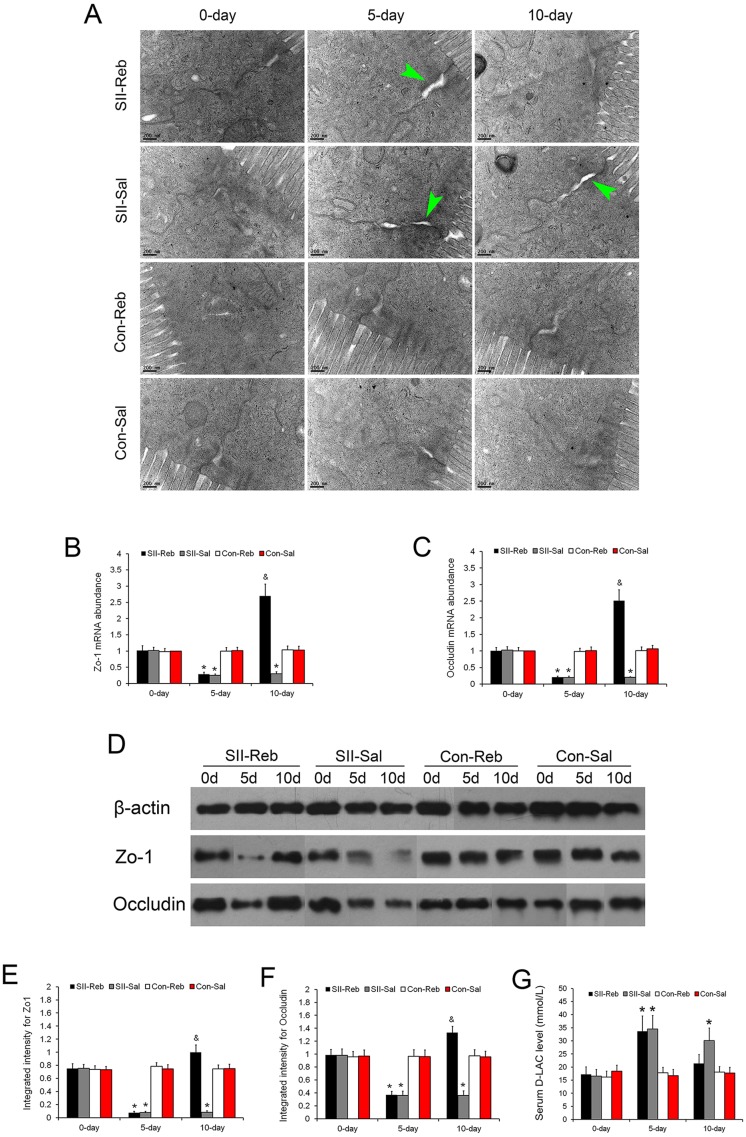
Intestinal barrier dysfunction in SII mice.(A) The tight junctions observed with TEM in SII-Reb mice at day 5 and SII-Sal mice at day 5 and at day 10 were significantly damaged. The wider intervals (green arrowheads) between the intestinal epithelial cells were indicated. (B-C) The mRNA expressions of Zo-1 (B) and Occludin (C) in the small intestine of the 4 groups were shown (n = 6, *P < 0.05 when compared with Con-Reb and Con-Sal groups; &
P < 0.05 when compared with SII-Sal, Con-Reb, and Con-Sal groups). (D-F) Protein abundances of Zo-1 (E) and Occludin (F) were indicated by Western blotting (n = 6, *P < 0.05 when compared with Con-Reb and Con-Sal groups; &
P < 0.05 when compared with SII-Sal, Con-Reb, and Con-Sal groups). (G) Serum levels of D-LAC in mice of the four groups were shown (n = 6, *P < 0.05 when compared with Con-Reb and Con-Sal groups).